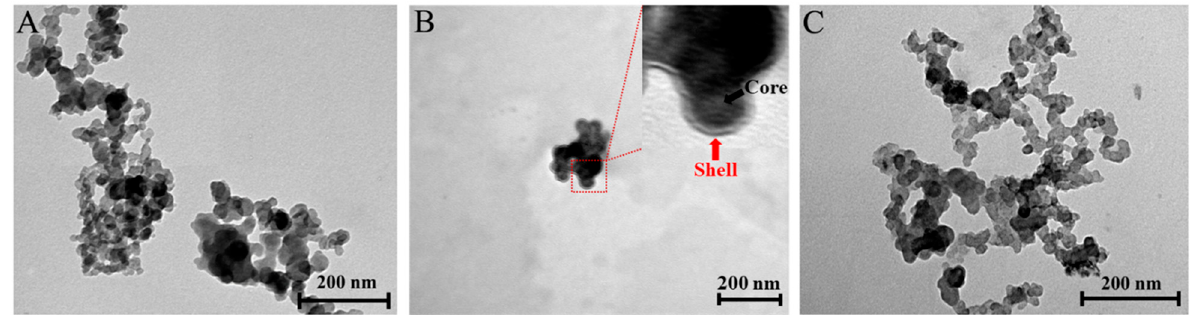
Figure 4. TEM images of ( A ) uncoated IONPs (60,000×), ( B ) Ch-IONPs (40,000×), and ( C ) CUR-2GE- Ch-IONPs (60,000×). The inset in ( B ) shows the core-shell structure of the optimized Ch-IONPs.